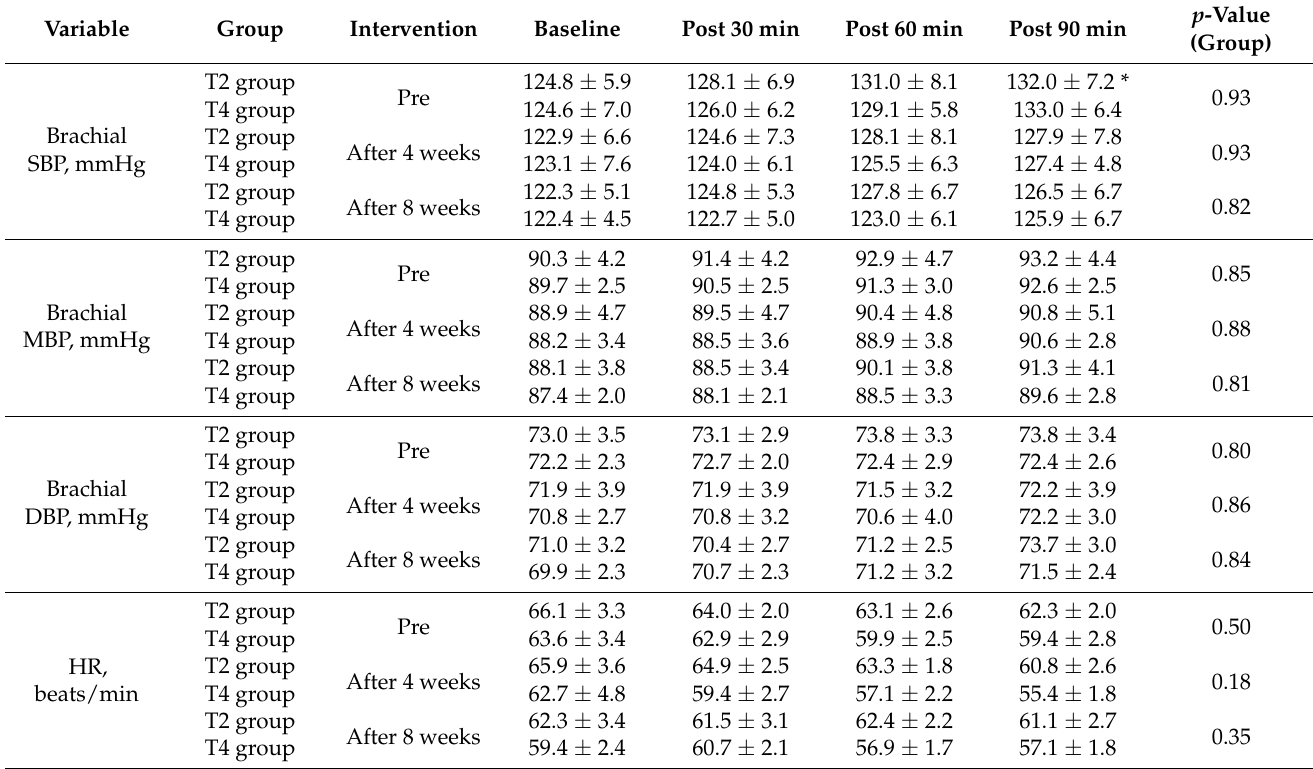
Table 2. Changes in brachial SBP, MBP and DBP before and after the 75-g OGTT of both